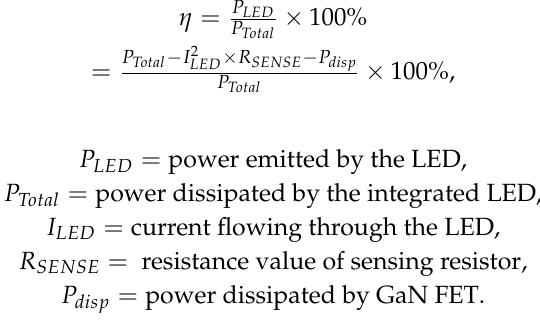
Figure 13. ( a ) Front side and ( b ) back side of PCB evaluation board.